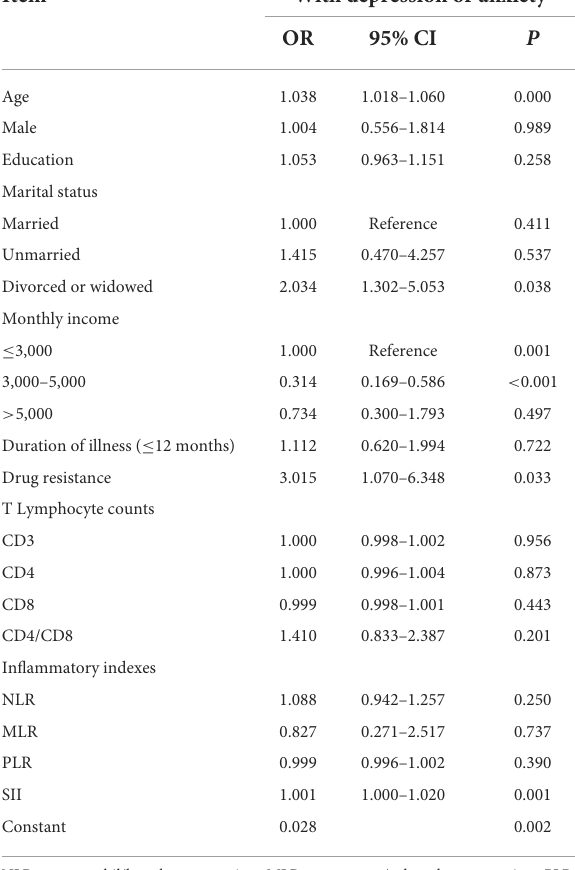
TABLE 3 Logistic regression analysis of associated factors in tuberculosis patients with depression or